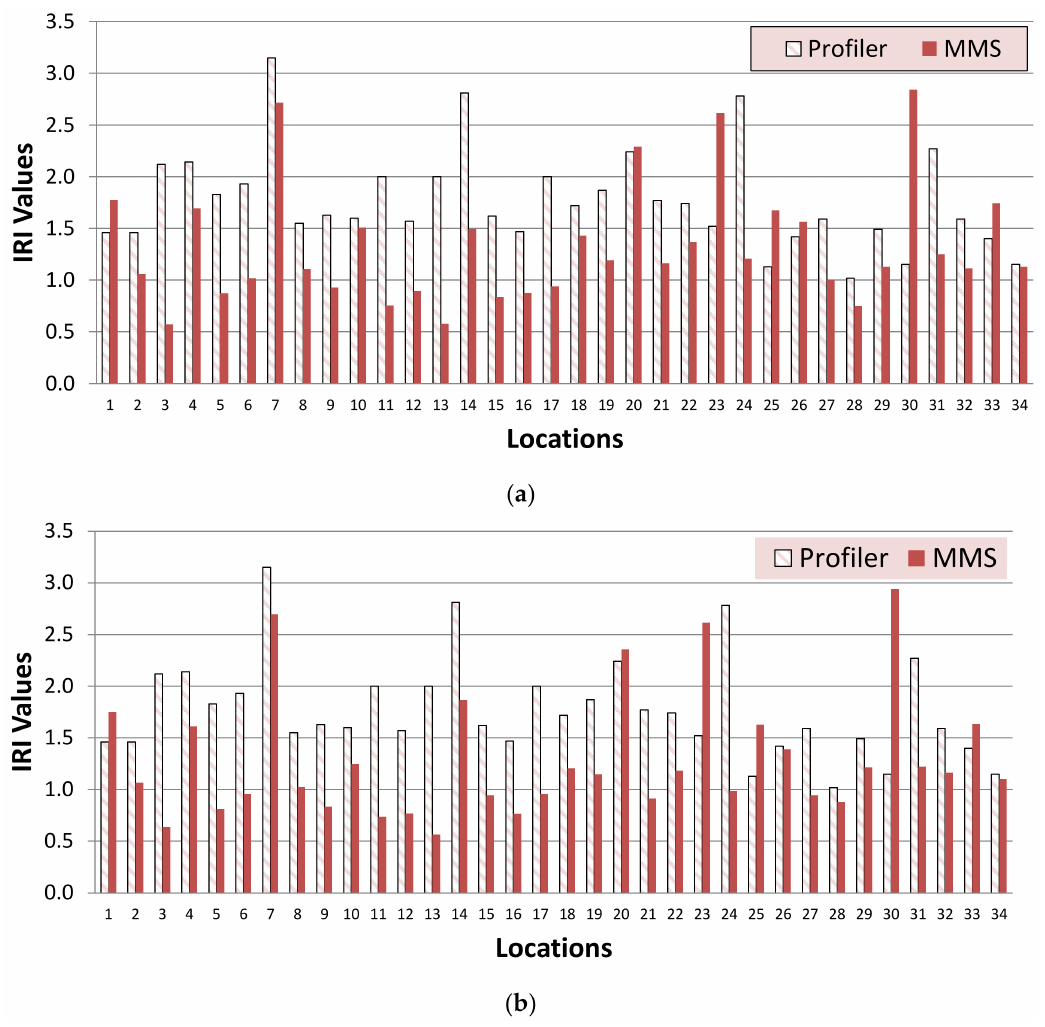
Figure 17. Comparison of IRI values measured by MLS and profilometer for ( a ) 5 cm mesh size and ( b ) 10 cm mesh